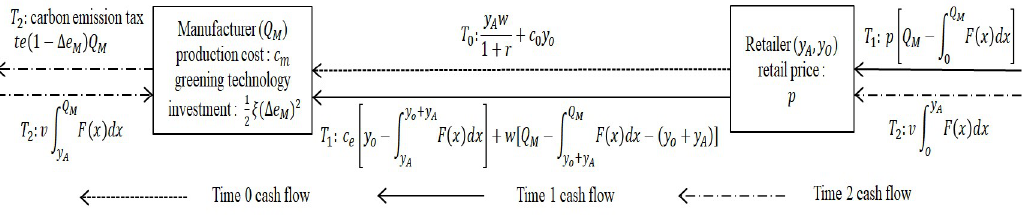
Figure 8. The cash flow of supply chain with PBO contract.